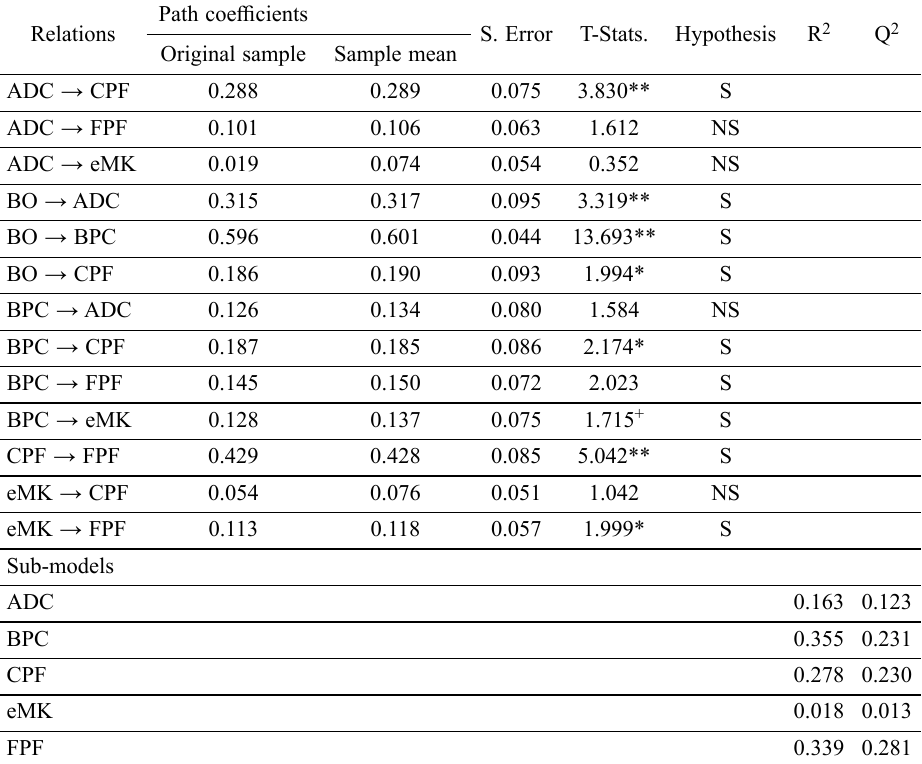
Table 4. Results of the structural model and hypotheses